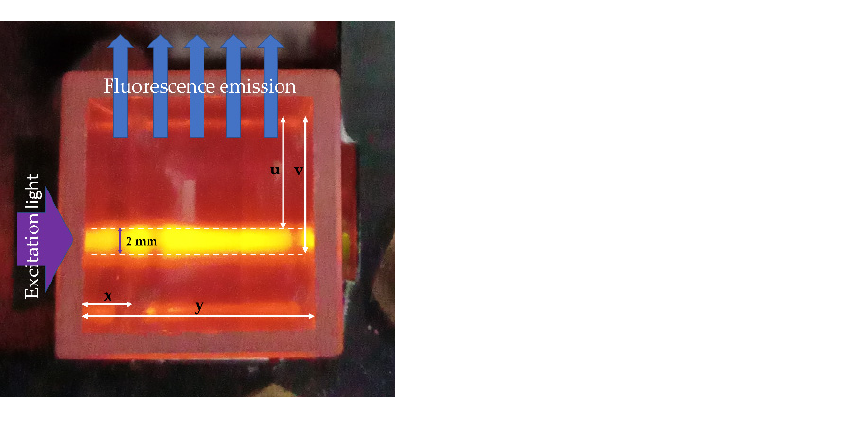
coefficient of the acceptor at λ [9]. The overlap integrals ( J ) were calculated from